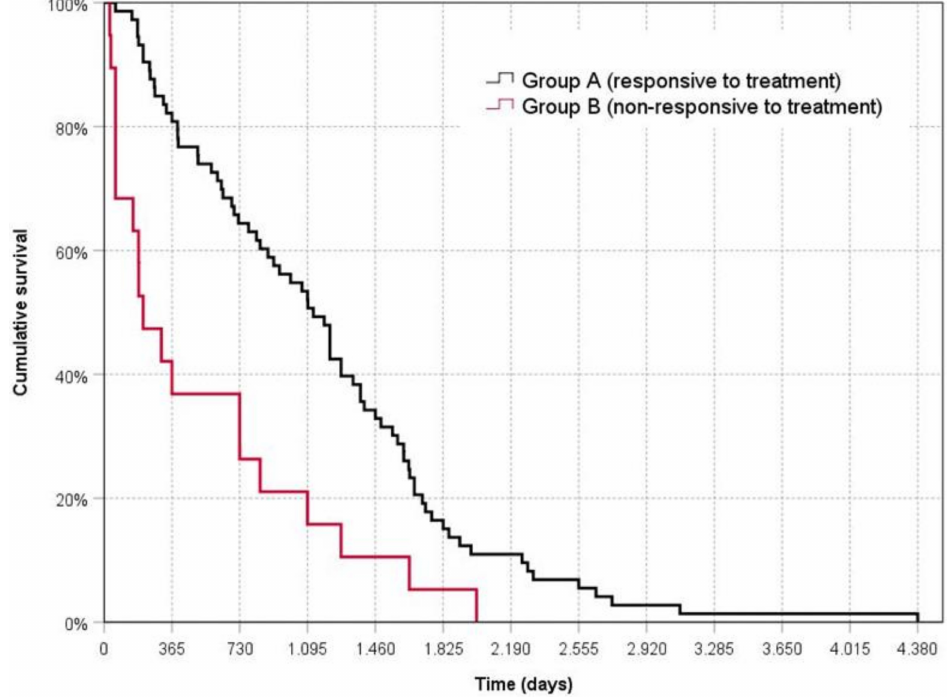
Figure 1. Kaplan—-Meier survival curve for dogs responsive or non-responsive to treatment. Time zero represents the date of